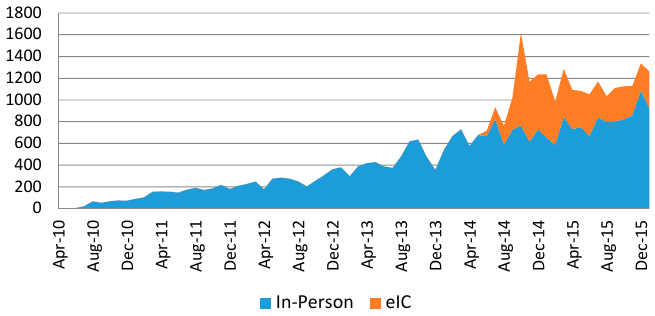
Figure 3. Timeline of the number of participants enrolled until January 2016 by in ‐ person consent (blue) and eIC (red), which began in June 2014.